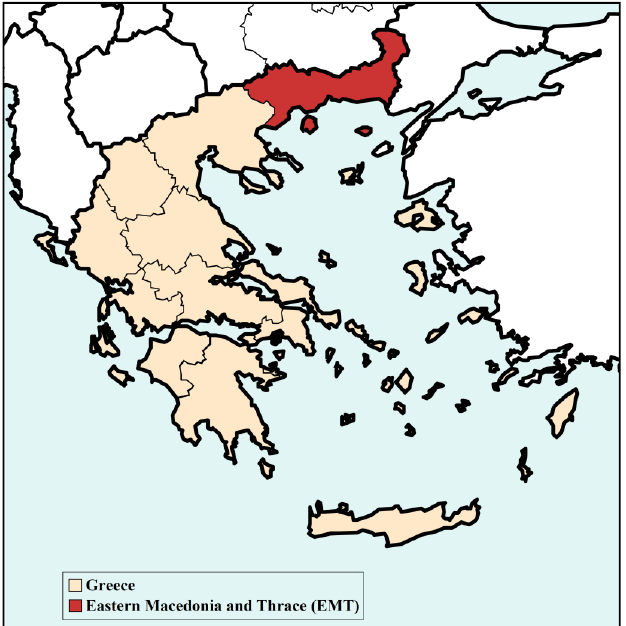
Figure 1. The region of Eastern Macedonia and Thrace (EMT) is colored in red.